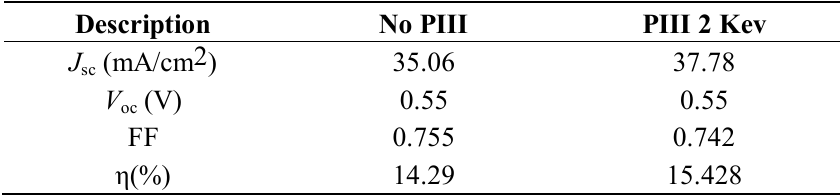
Table 4. The summary table of without PIII & PIII 2 KeV 10 min heterojunction solar cells without AlO x